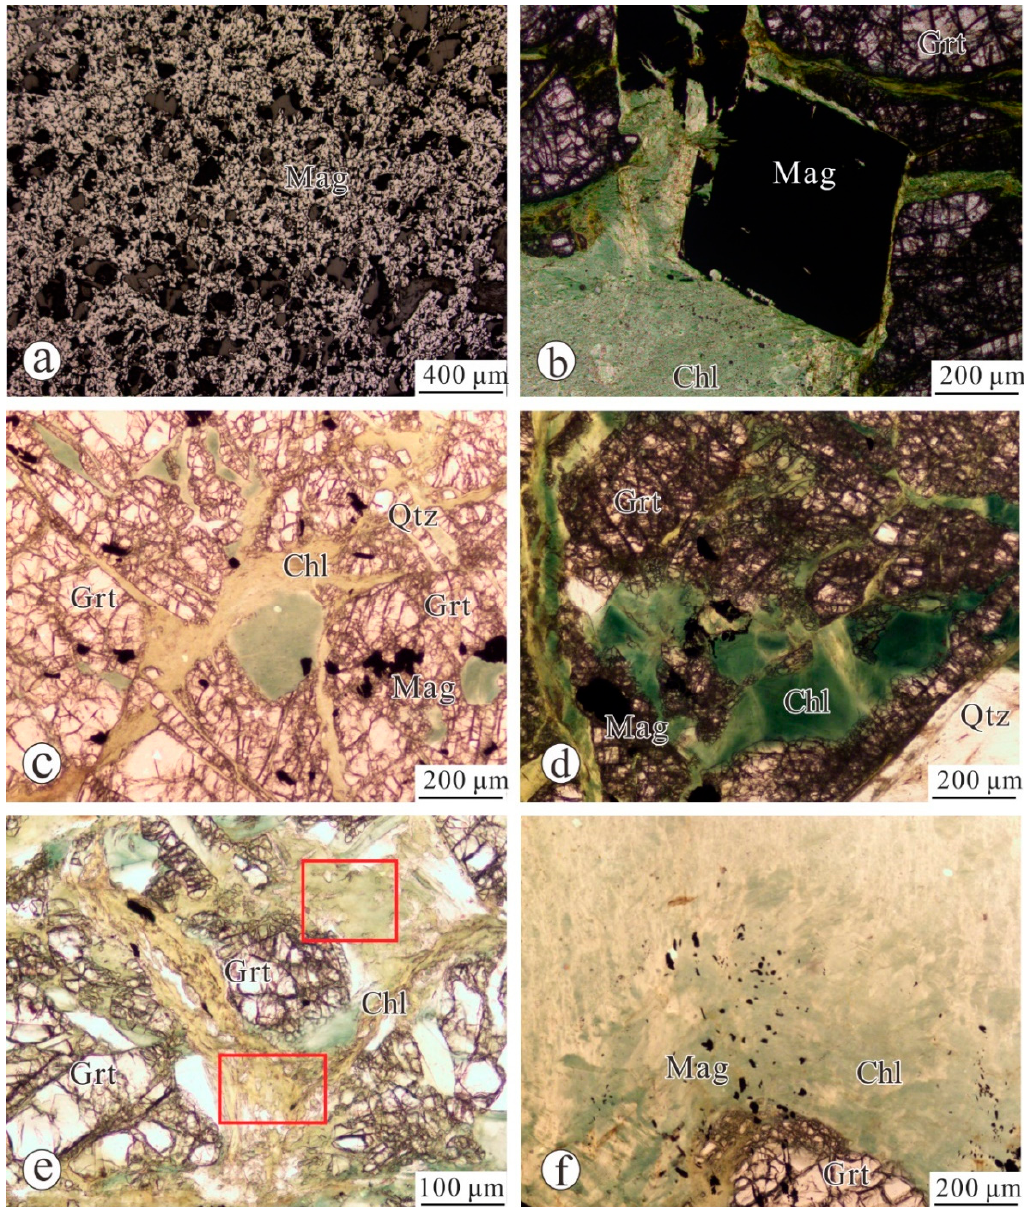
Figure 6. Photomicrographs showing the representative mineral assemblage and texture of iron ore and wall-rock from the Gongchangling number 2 mining area. ( a ) high-grade magnetite (Mag) under a reflected light microscope; ( b ) magnetite of large grain size ( c ) chlorite garnetite consisting of garnet (Grt) and chlorite (Chl), showing porphyroblastic texture (plane-polarized light); ( d ) garnetic chloritite; ( e ) and ( f )